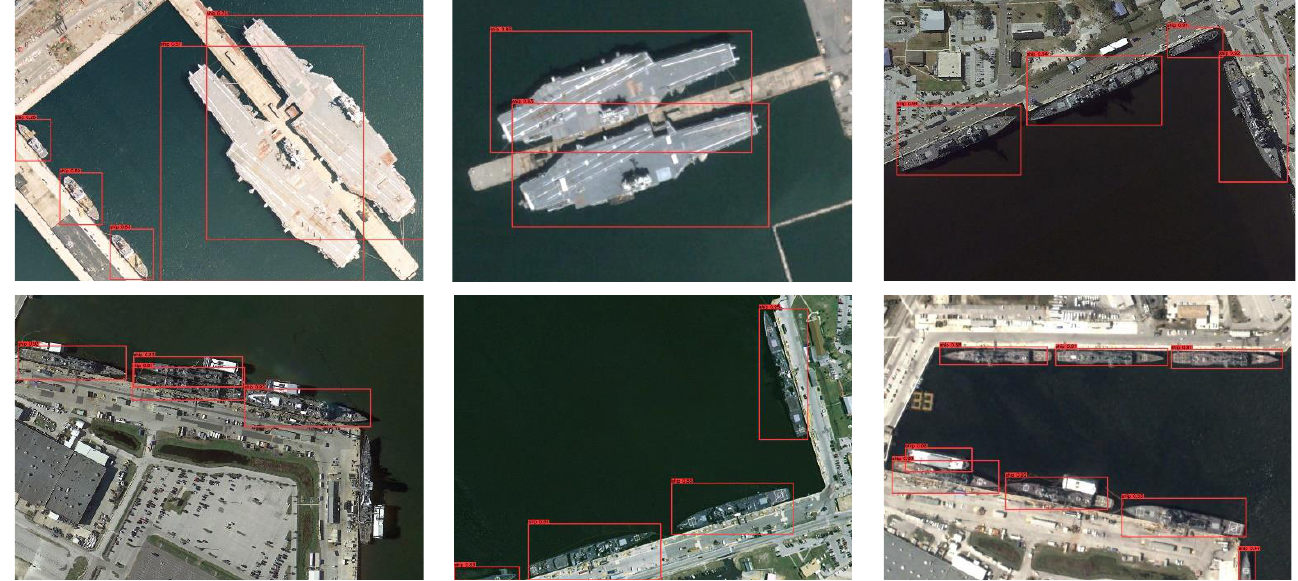
Figure 14. Visualization results on the HRSC2016 dataset.